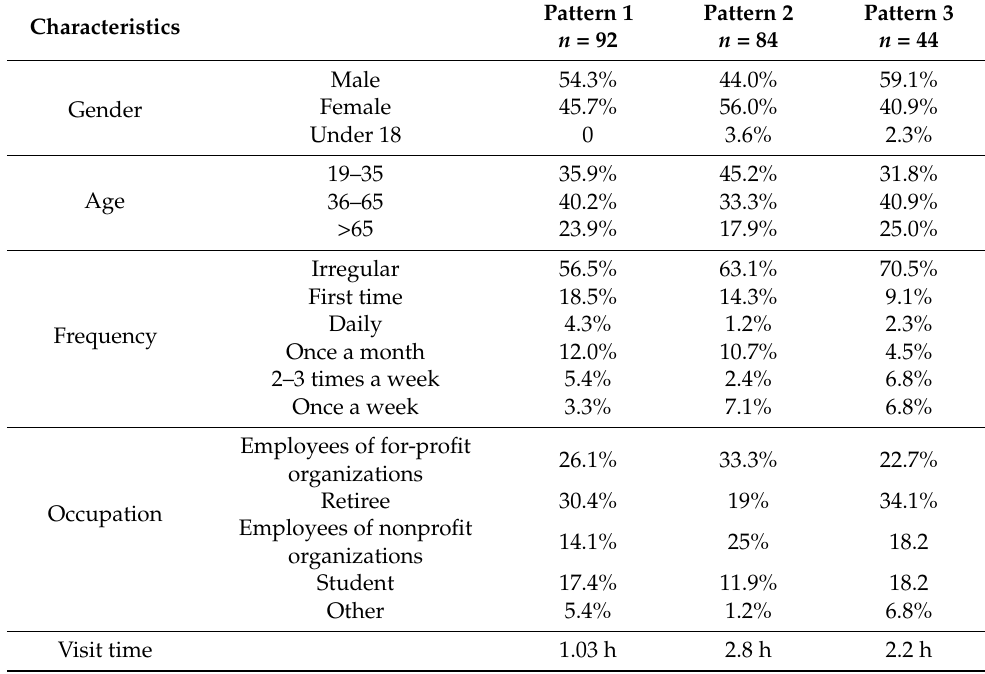
Table 3. Social characteristics of the tourists in different patterns.